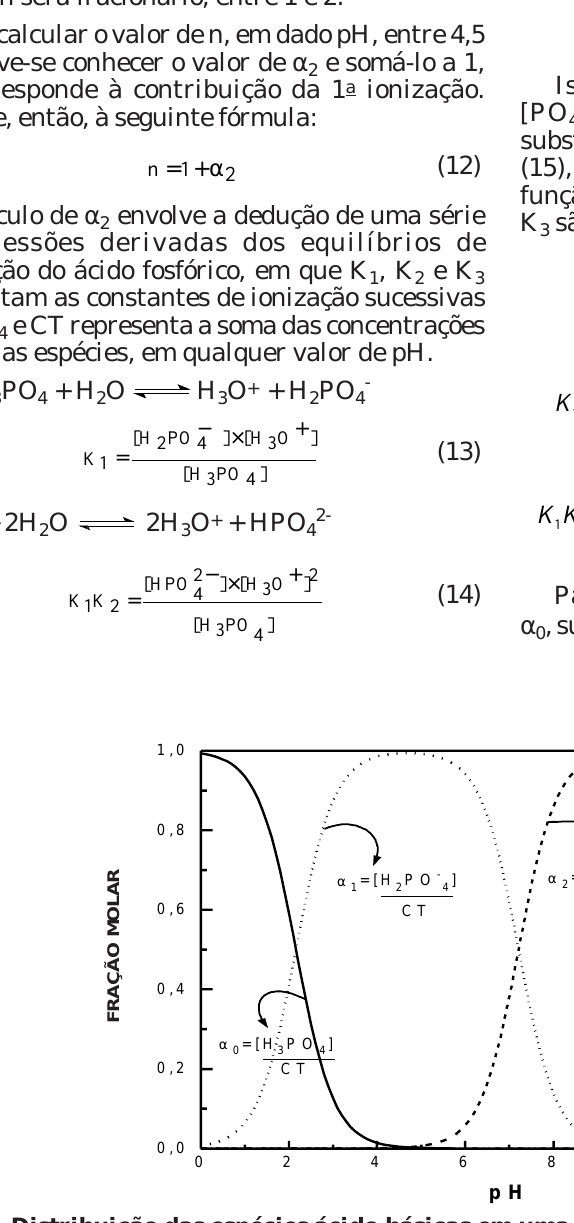
Figura 1. Distribuição das espécies ácido-básicas em uma solução de ácido fosfórico em função do